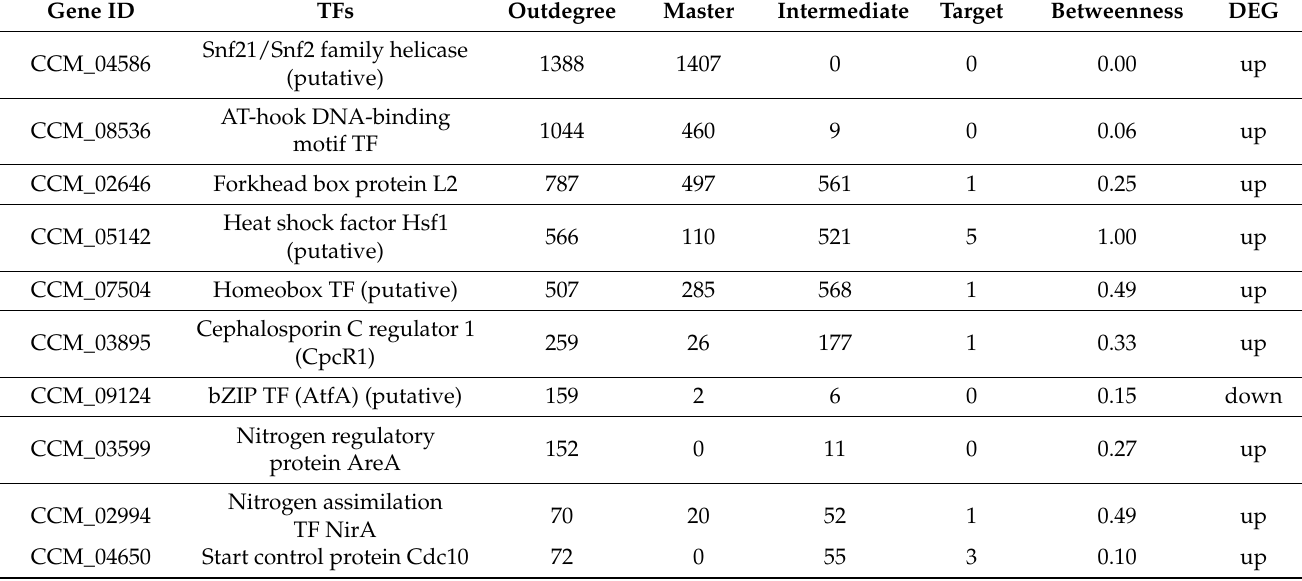
Table 1. Node measures of 10 TFs in the light-responsive